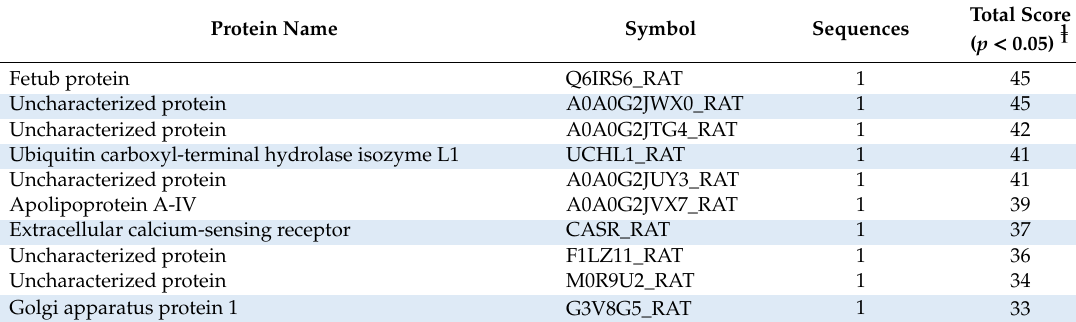
Table 2. Deiminated proteins in pre-motor PD rat plasma ( Rattus norvegicus ), as identified by F95-enrichment and LC-MS / MS analysis. Deiminated proteins from pre-motor PD rat plasma